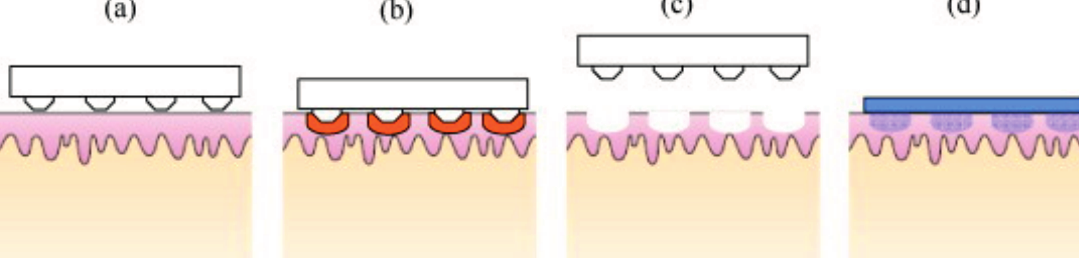
Figure 12. Schematic diagram of drug delivery using thermal ablation: ( a ) micro-electrodes are pressed against the skin, ( b ) skin is ablated via heating due to RF energy or resistive heating in the electrodes, ( c ) after removing the ablation device, ( d ) micropores formed. (Reprinted from [11] with permission. Copyright 2008